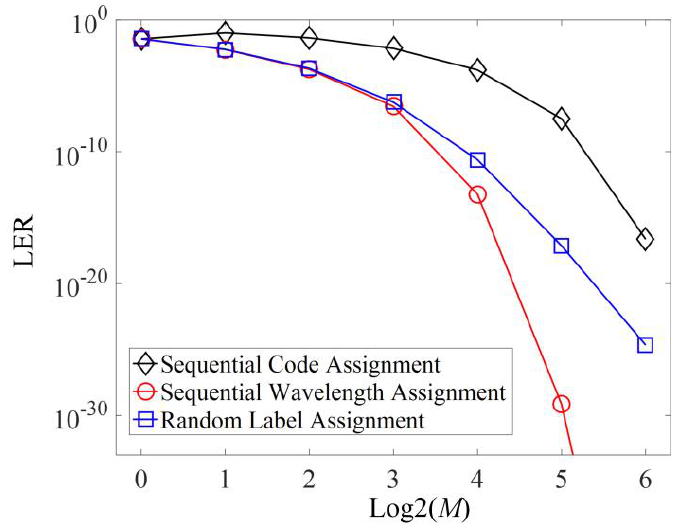
Figure 8. LER versus WDM channel number M . for the three label stacking scenarios.